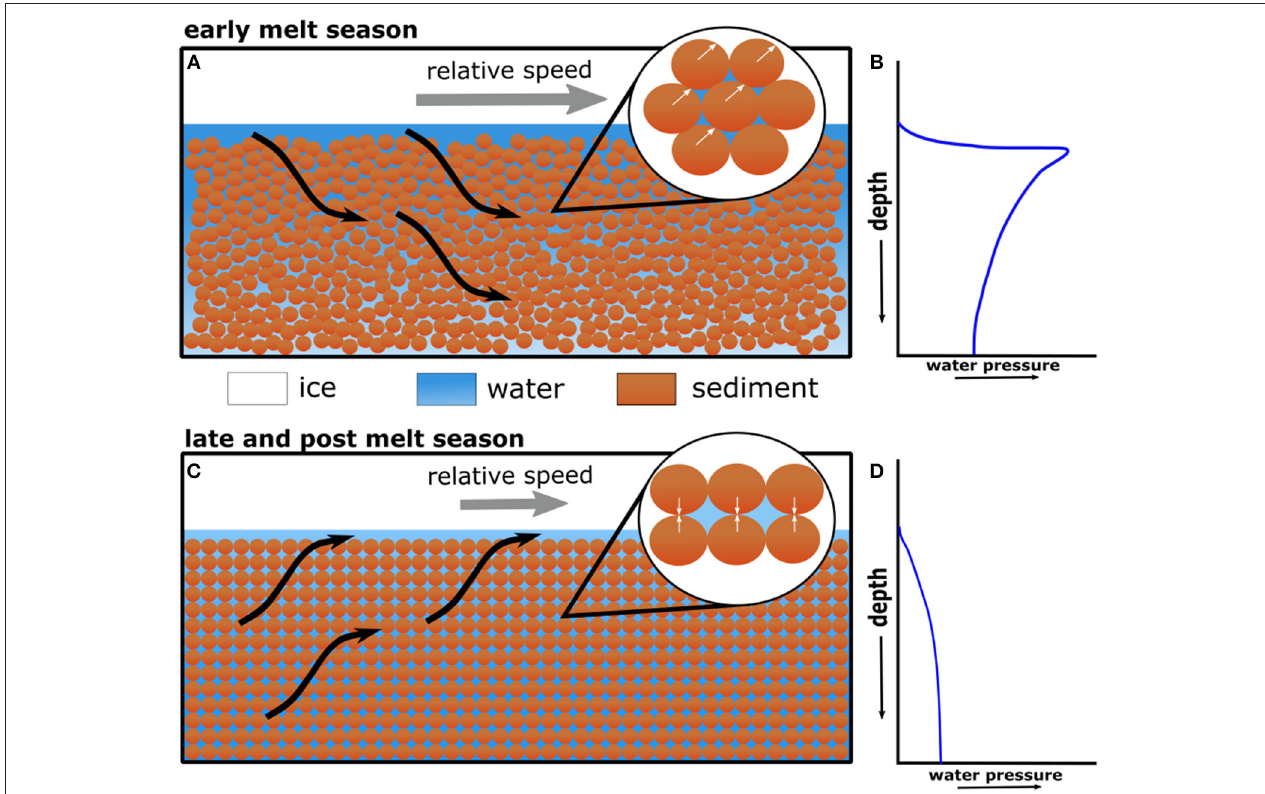
FIGURE 5 | Schematic of the sediment deformation mechanism proposed by Bougamont et al. (2014). (A) Pulses of meltwater (black arrows) during the early-melt season force water downward along a vertical hydraulic gradient (idealised in B ). A consequent reduction in sediment shear strength facilitates particle displacement (white arrows, top zoom), leading to (C) grain rearrangement, increased sediment porosity, and (D) lower water pressure and therefore stronger inter-particle contacts (white arrows, bottom zoom) during the late-melt season.